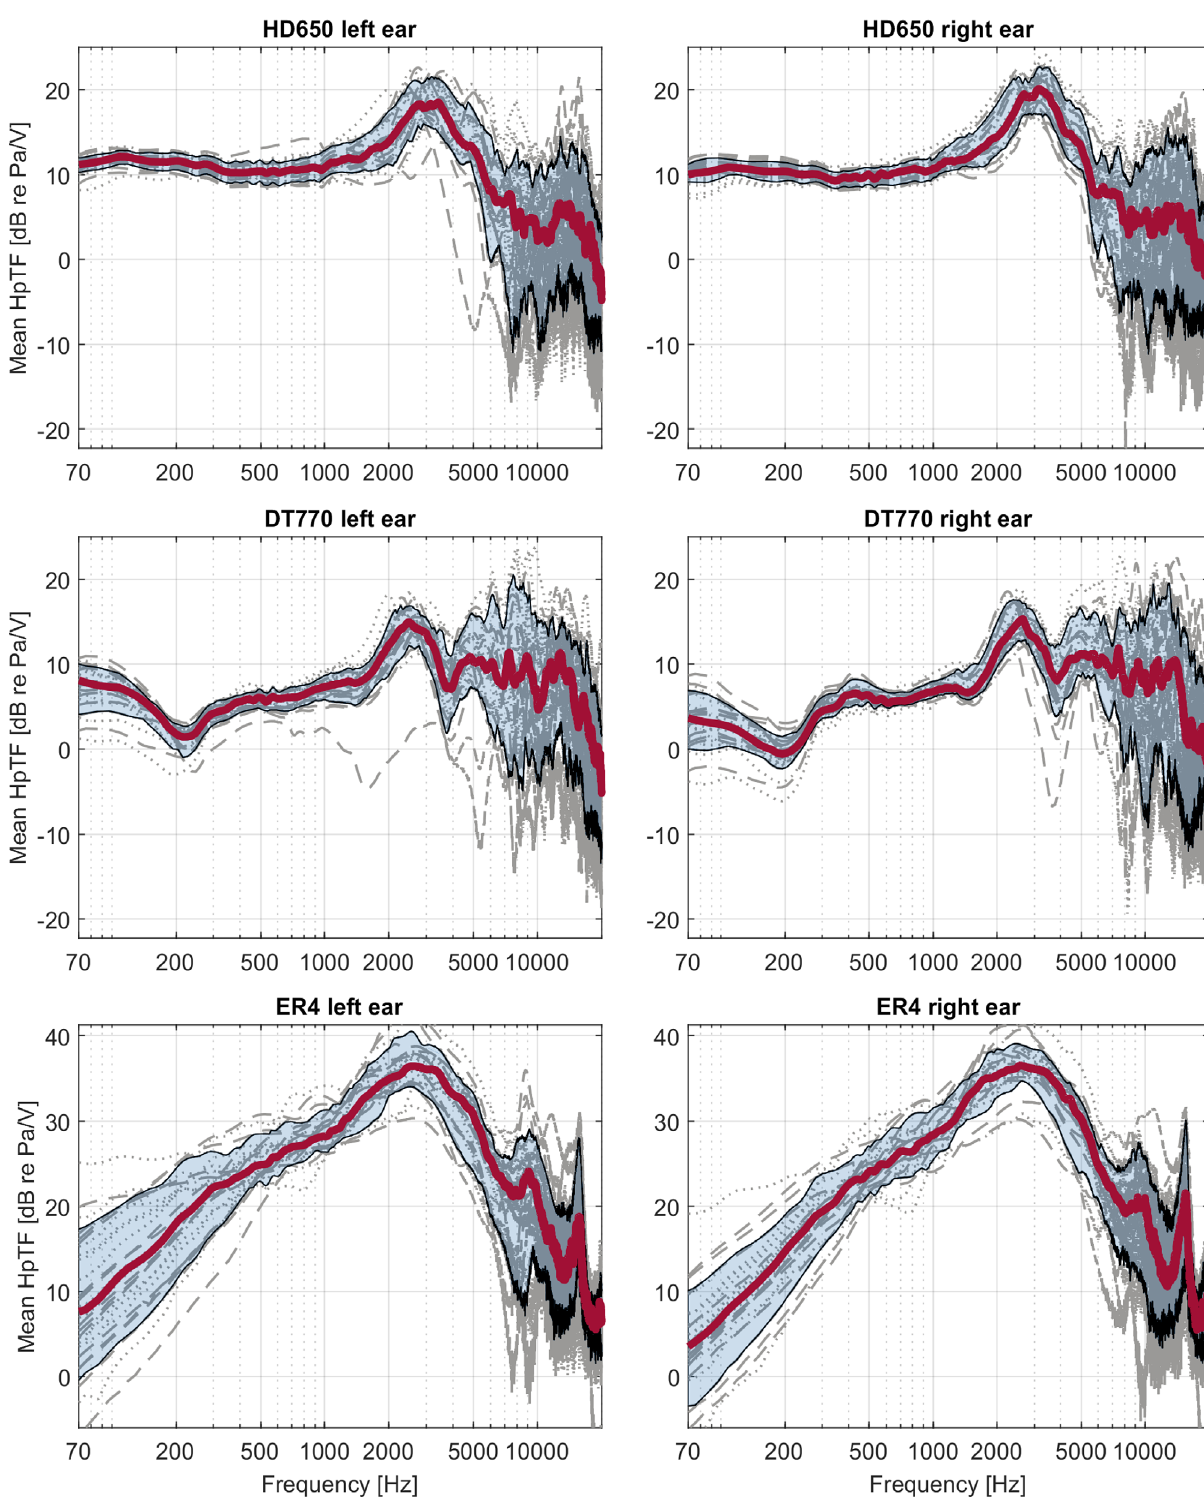
Figure 2. HpTF magnitude levels for participants measured in Aachen and Oldenburg separated by left and right ear. Plotted is the mean over eight repetitions of the frequency magnitude. The sound pressure was measured close to the eardrum using probe tubes. The range of the y -axis differs for the ER4 measurements at the bottom. Red line shows the median, in transparent blue the range of 75% of measurement data around the median is plotted. Gray lines indicate the mean of one individual participant over up to eight repetitions. Dashed lines indicate a measurement in Aachen, dotted lines measurements in